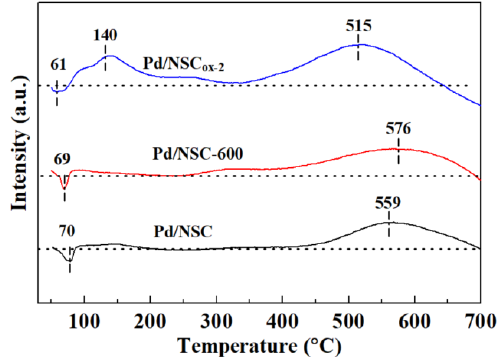
Figure 8. TPR profiles of the various